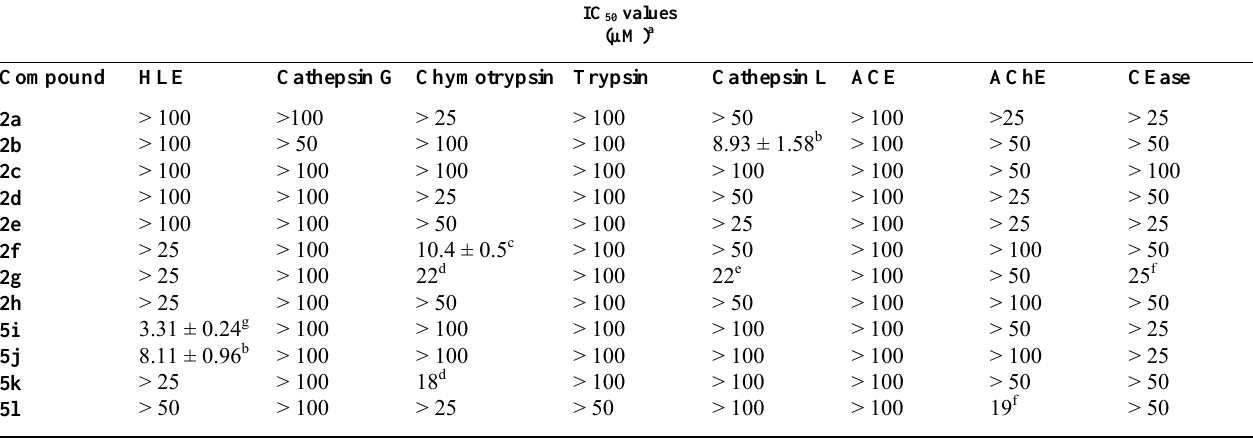
Table 1. Enzyme inhibitory activities of 2-amino and 2-alkylthio-4 H -3,1-benzothiazin-4-ones.